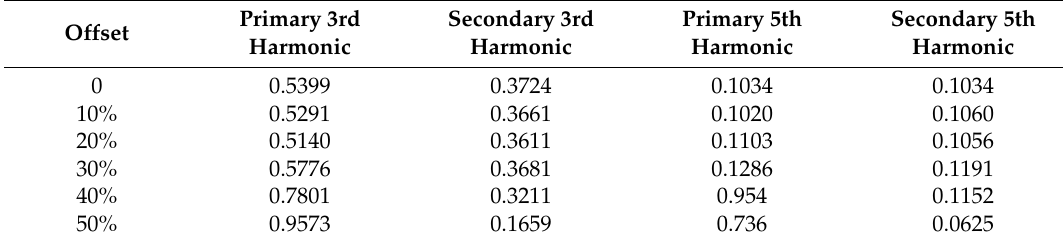
Table 8. Harmonic currents with the offset (A/m).